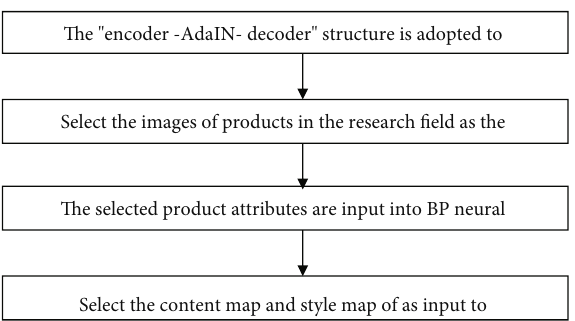
Figure 2: Style transfer model construction process.